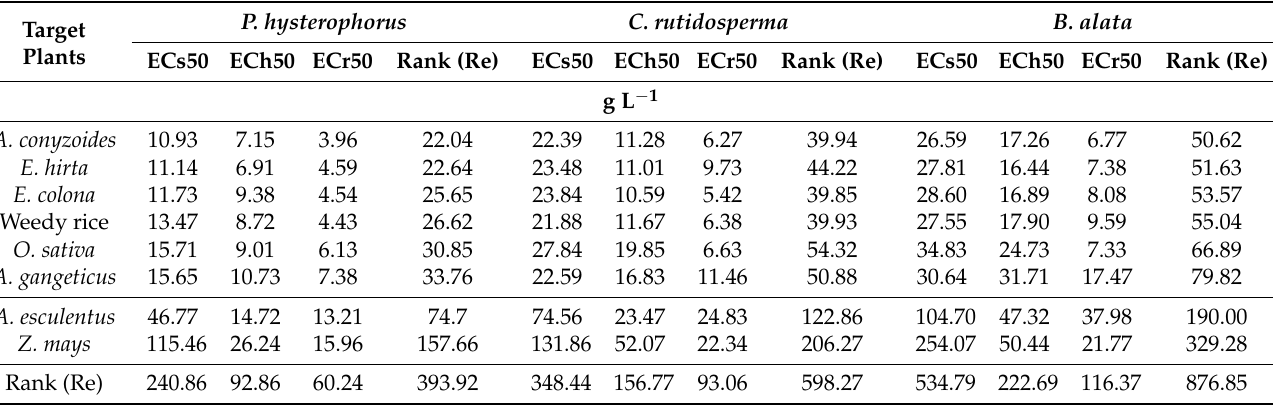
Table 3. EC 50 and rank value (Re) of P. hysterophorus , C. rutidosperma , and B. alata methanol extract for the tested species.